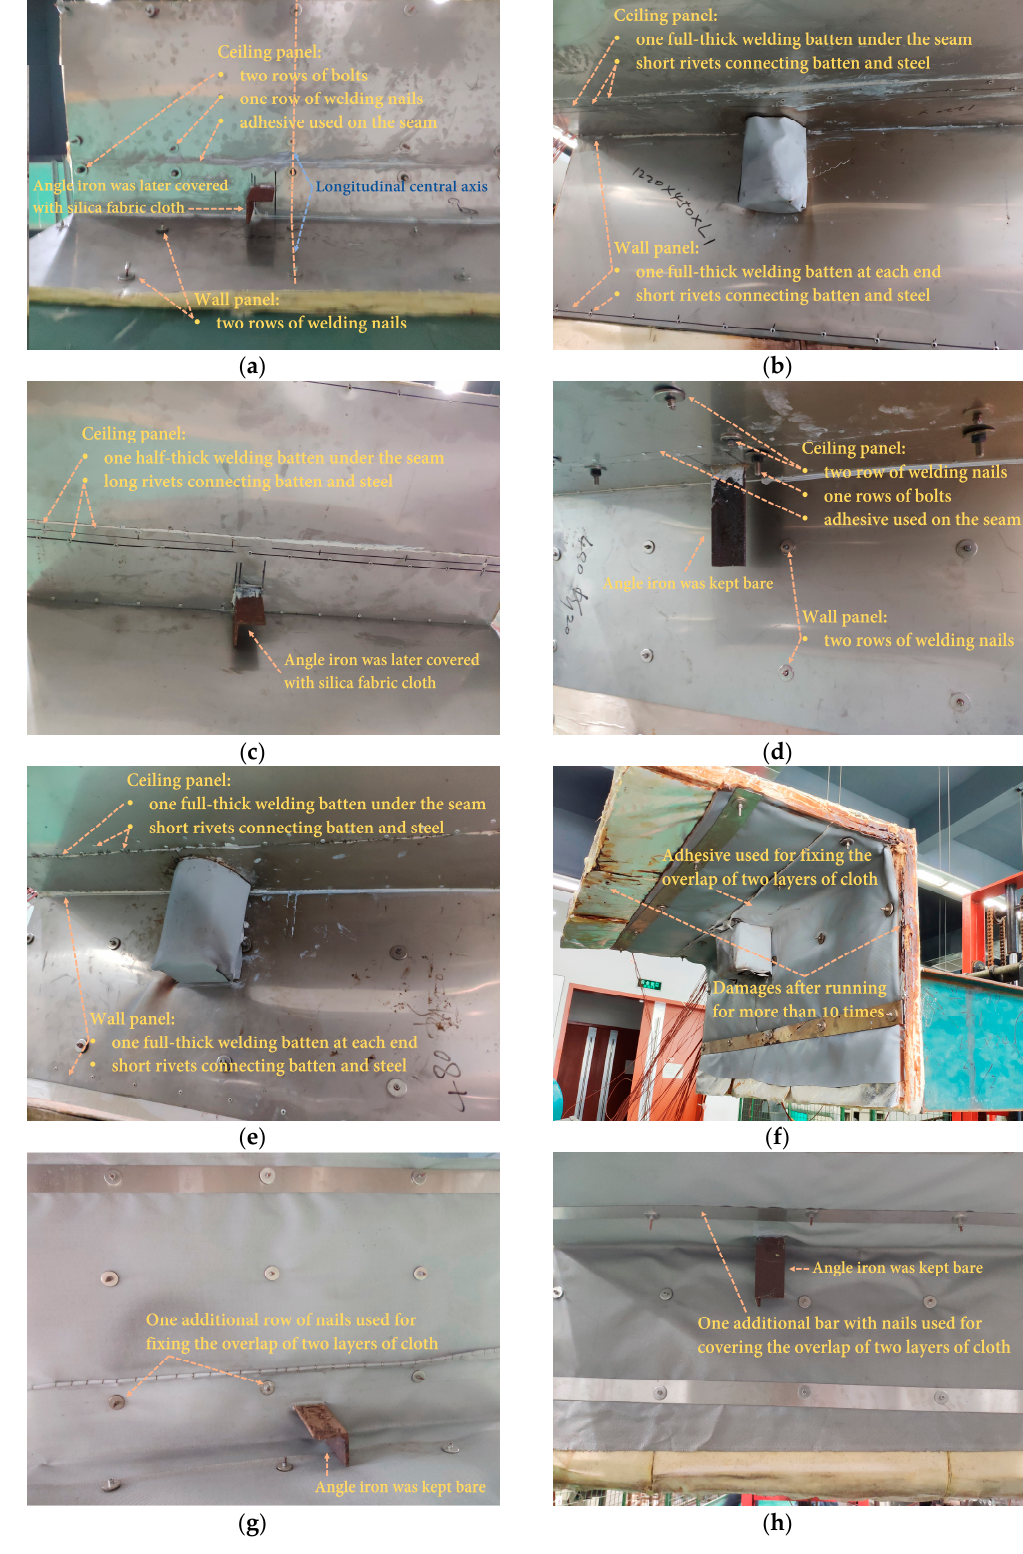
Figure 2. Images of sandwich specimens at different stages of the experiment: ( a ) Specimen 1 prior to testing; ( b ) Specimen 2 after two tests; ( c ) Specimen 3 prior to testing; ( d ) Specimen 4 after two tests; ( e ) Specimen 5 prior to testing; ( f ) Specimen 6 after testing more than 10 times, mostly pre-experiment, and lifted by a forklift; ( g ) Specimen 7 after two tests; and ( h ) Specimen 8 after two tests.